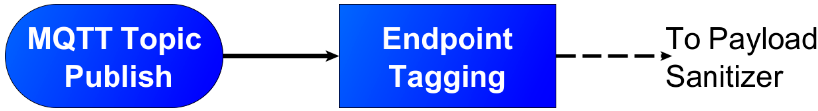
Figure A3. MQTT topic subscriber-based data ingest step for device data integration.